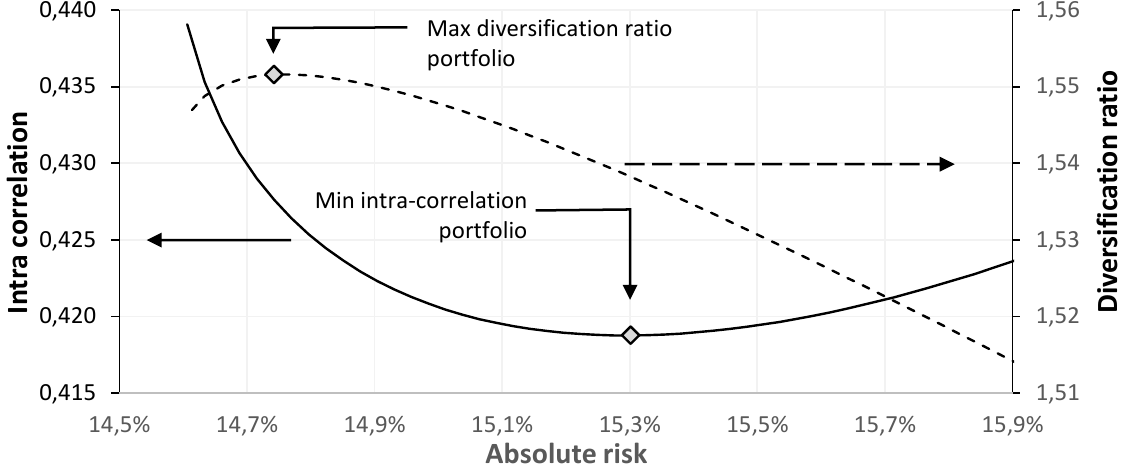
Figure 3. Intra-correlation and diversification ratio subject to a TE = %7